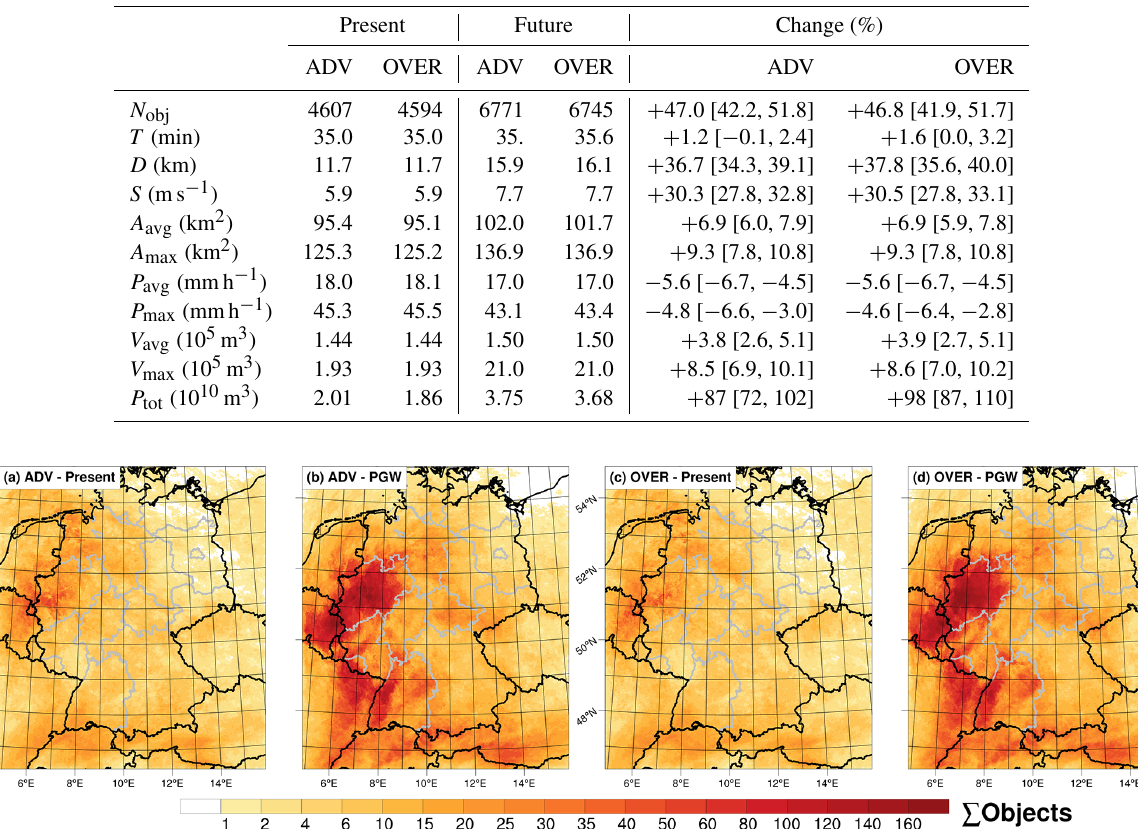
Table 1. Present, future and relative change values of N obj and all object properties, for the ADV and OVER tracking algorithms. The results are based on the reference setup (Sect. 4.1): A min = 8 grid boxes, P min = 8 . 5mmh − 1 and T min = 15min. For display purposes, the table entries have been rounded, which explains any slight deviations of the relative changes from that expected based on the present and future entries. Square brackets denote confidence intervals, computed as described in Sect. 3.4.